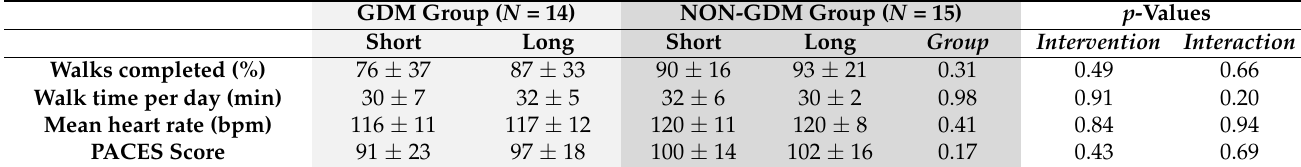
Table 6. Compliance and adherence to the exercise intervention for LONG and SHORT protocols between GDM and NON-GDM. GDM Group ( N = 14) NON-GDM Group ( N = 15) p -Values Short Long Short Long Group Intervention